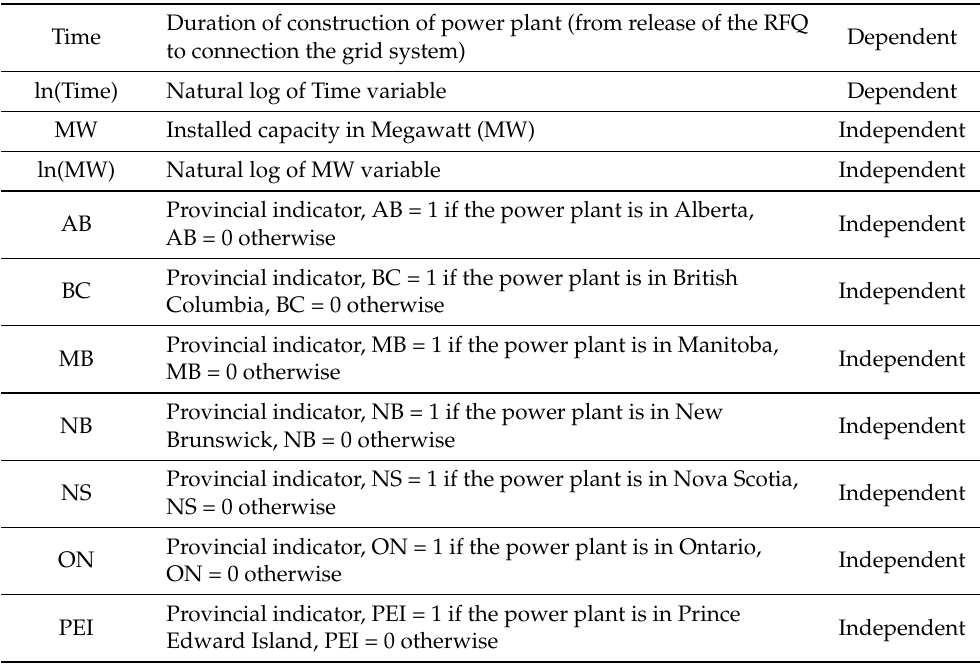
Table A1. Definition of variables for models of power plants (Hydro, Nuclear,